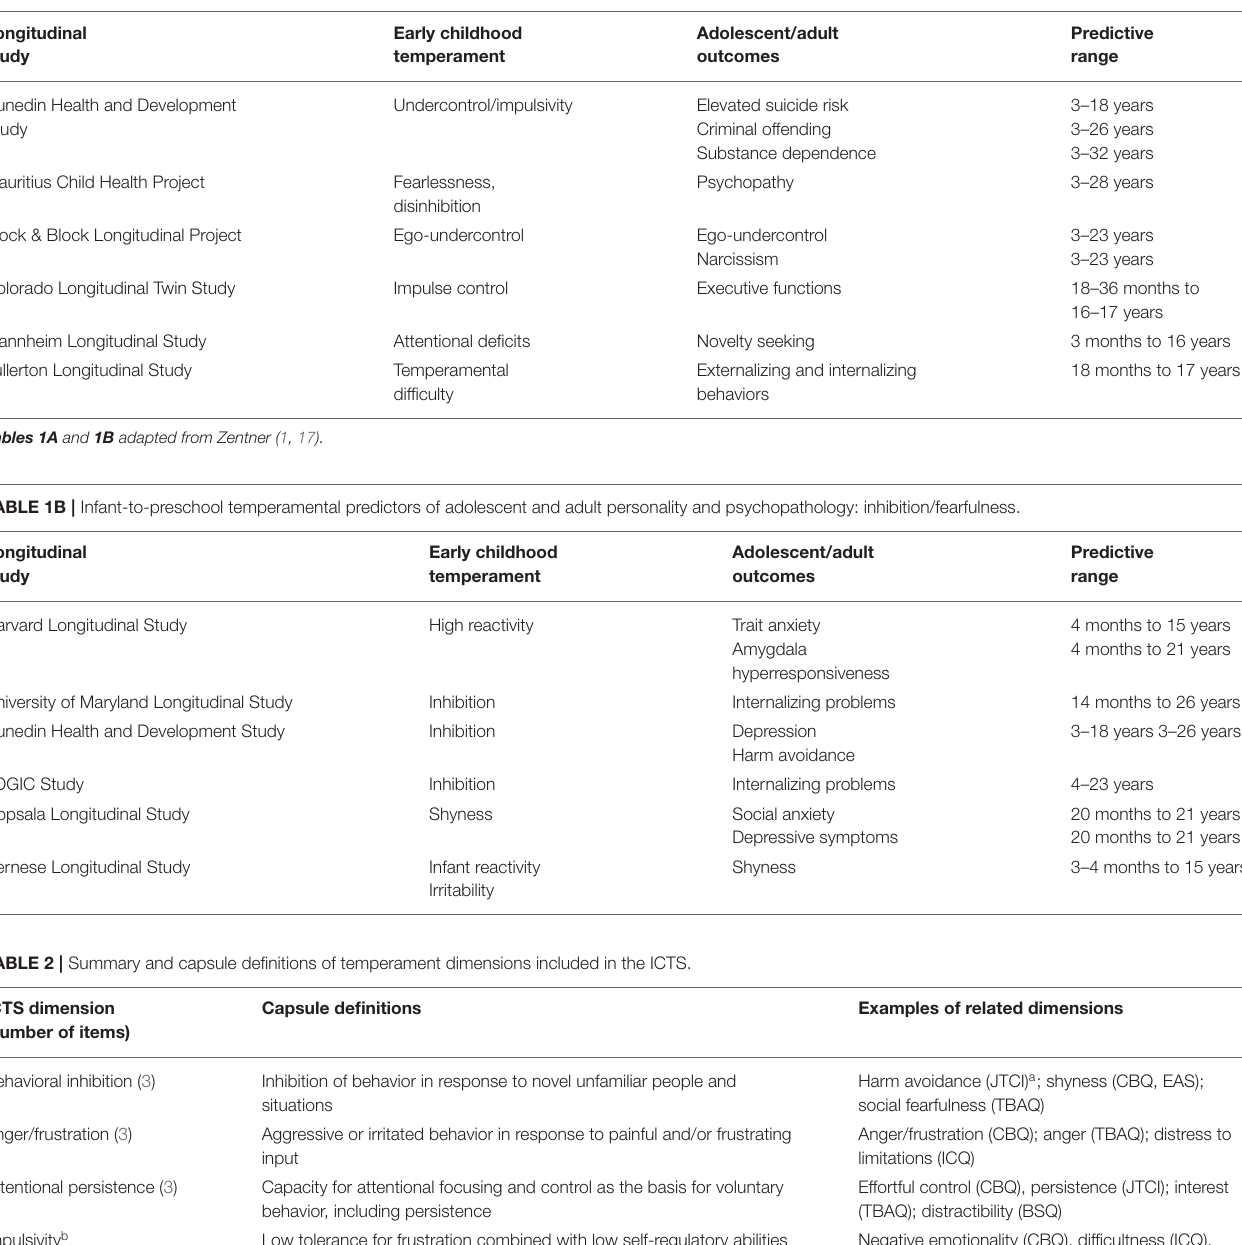
TABLE 1A | Infant-to-preschool temperament predictors of adolescent and adult personality and psychopathology: undercontrol/inattention.